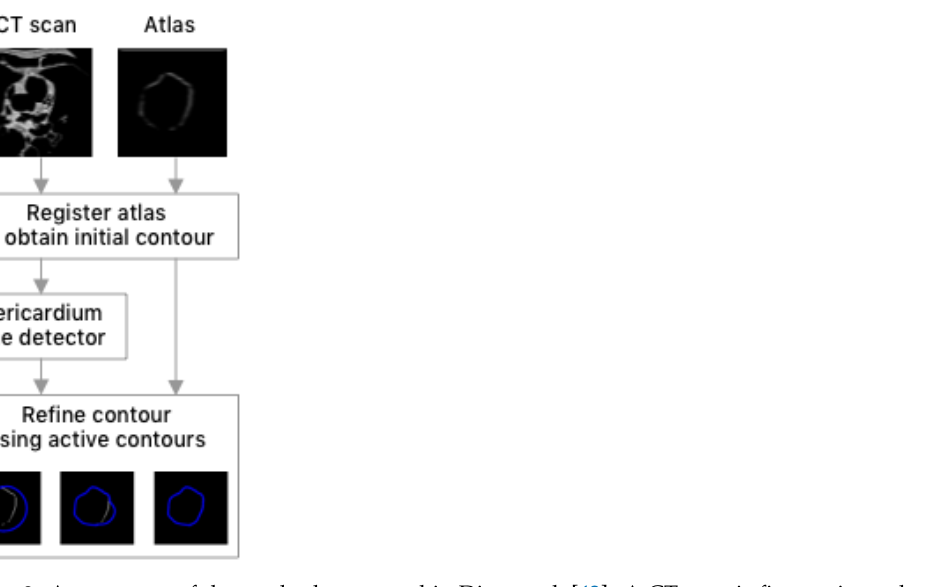
Figure 9. A summary of the method presented in Ding et al. [42]. A CT scan is first registered to obtain an initial counter and a line detector is used to find the pericardium line. The detected line is refined using active